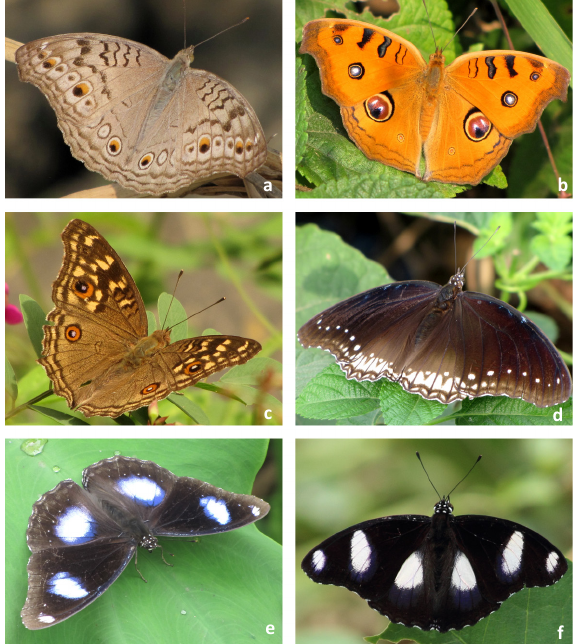
Image 6. Butterflies representing the family Nymphalidae in and around RRS, Chinsurah. a - Grey Pansy J. athletes (Linnaeus); b - Peacock Pansy J. almana (Linnaeus); c - Lemon Pansy J. lemonias (Linnaeus); d - Great Eggfly H. bolina (Linnaeus) female; e - Great Eggfly H. bolina (Linnaeus) male; f - Danaid Eggfly H. misippus (Linnaeus). ©